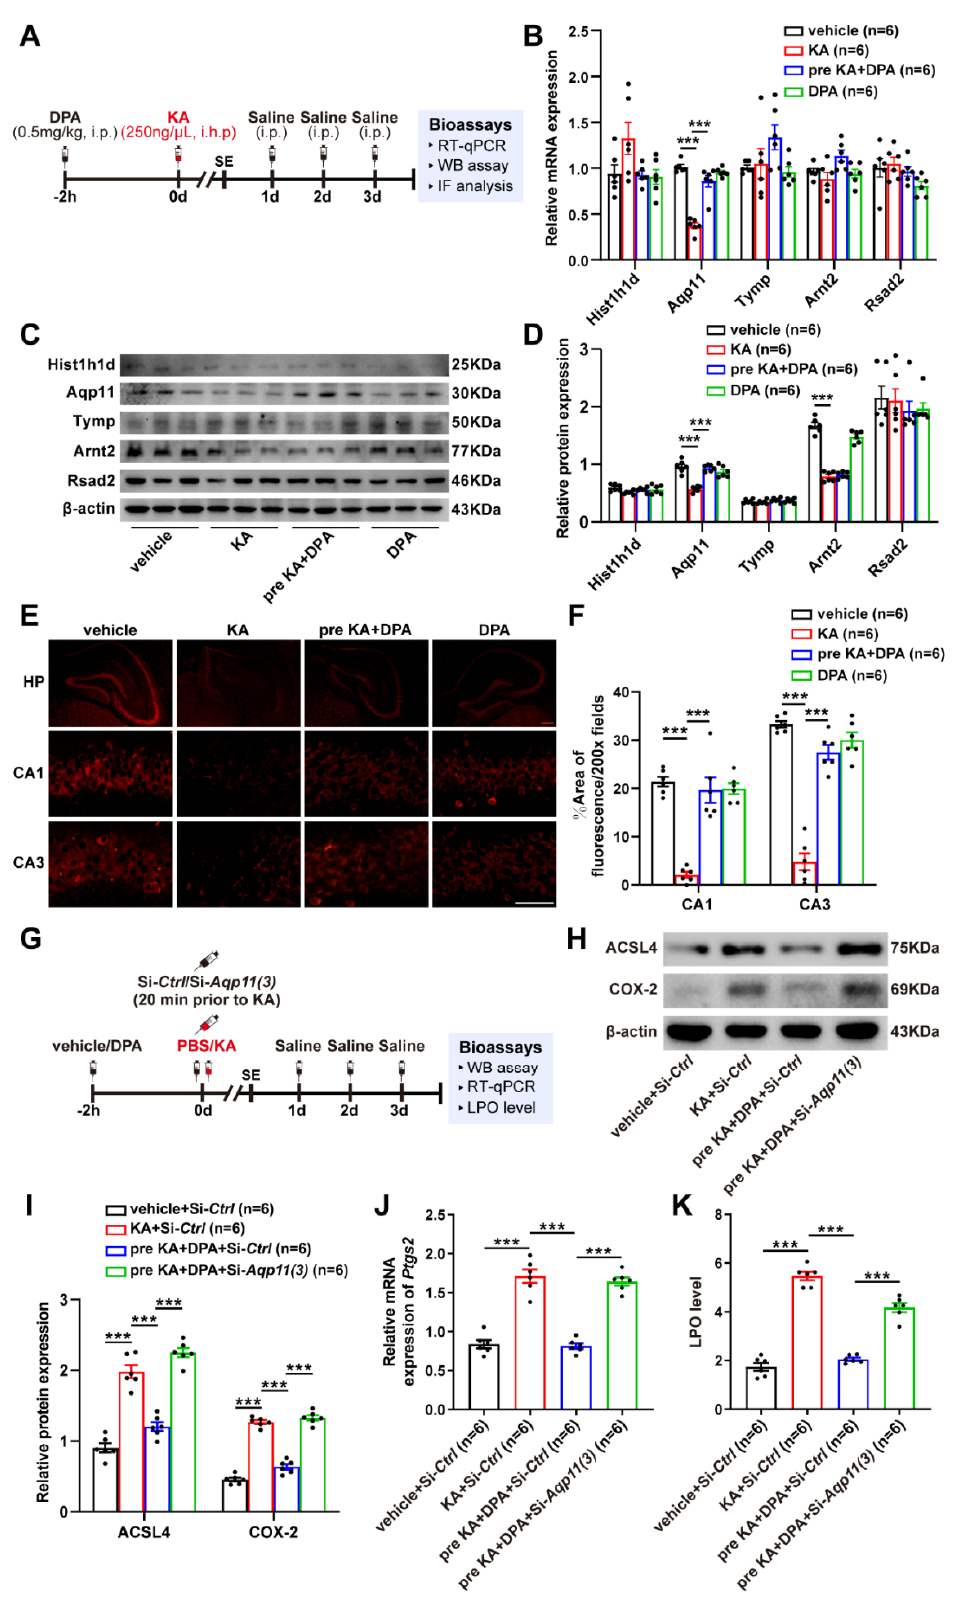
Figure 6. DPA attenuates KA-induced seizures via inhibiting Aqp11 -dependent ferroptosis. ( A ) Experimental timeline. Bioassays including RT-qPCR, WB, IF and detection of LPO level were carried out 3 d after KA (250 ng/ μ L) or PBS injection. ( B , C ) Effects of DPA (0.5 mg/kg) on the mRNA and protein expressions of Hist1h1d, Aqp11 , Tymp, Arnt2 and Rsad2 in KA-treated mice by RT-qPCR